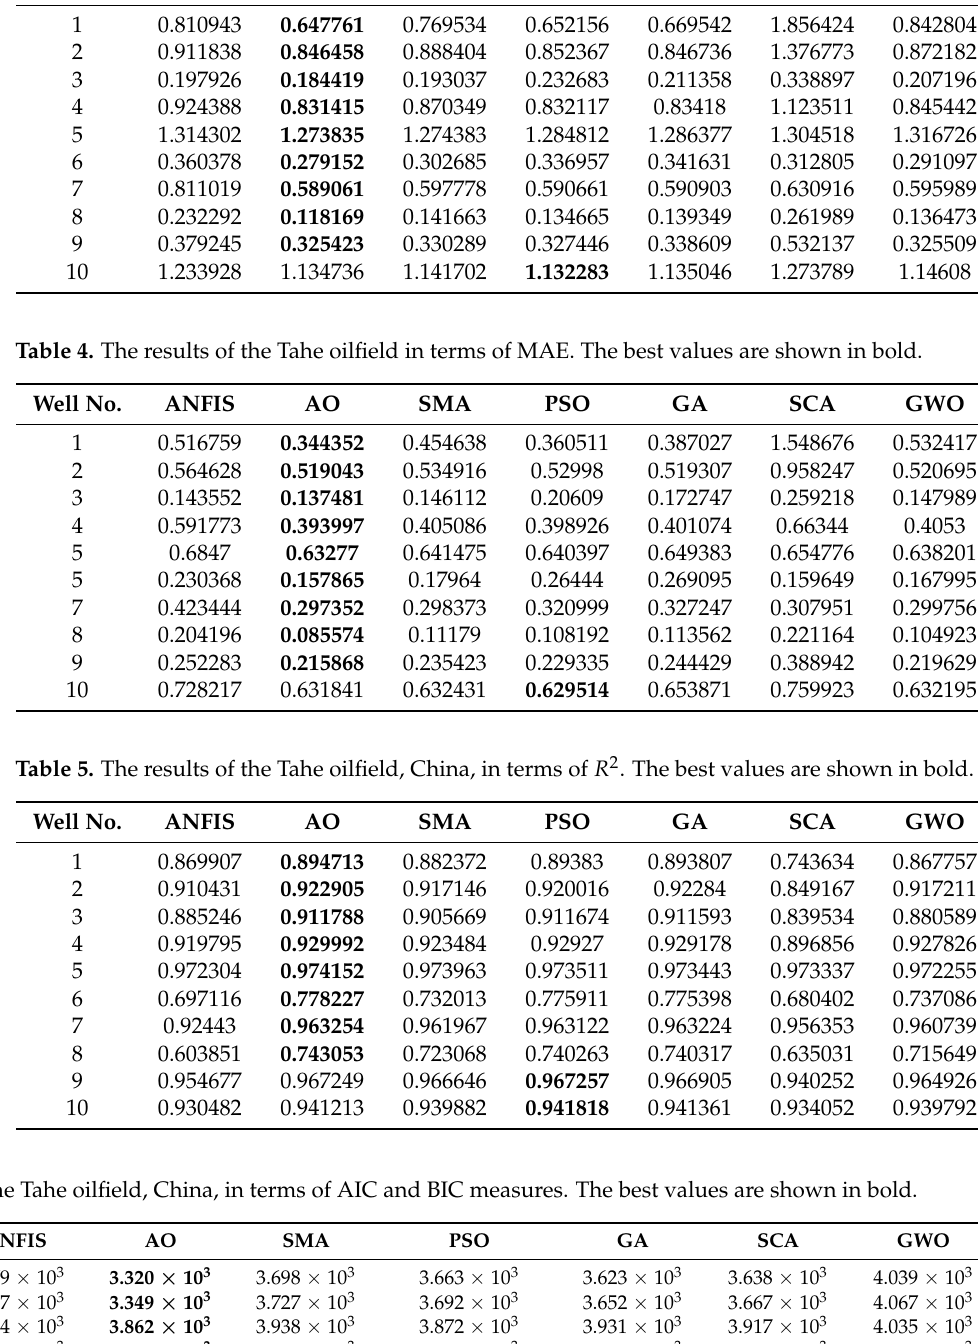
Table 3. The results of the Tahe oilfield in terms of RMSE. The best values are shown in bold. Well No.